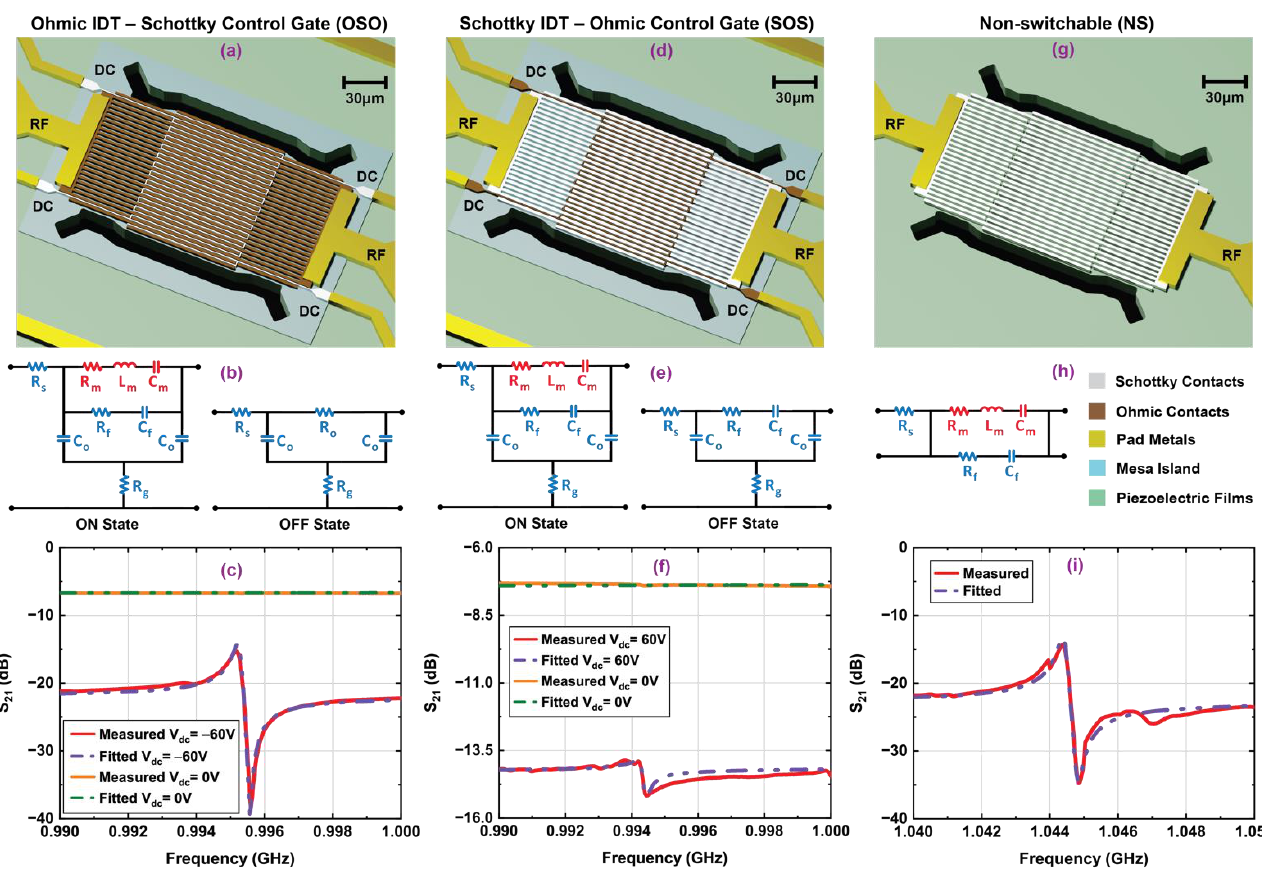
Figure 5. Three-dimensional schematic representation, equivalent circuit models and measured frequency responses along with fitted curves for switchable resonators: ( a – c ) Ohmic – Ohmic IDT with Schottky control gate (OSO), ( d – f ) Schottky – Schottky IDT with Ohmic control gate (SOS), and ( g – i ) non-switchable (NS) transducers. Both OSO and SOS have control gate width 0.6 µm, and all resonators have IDT width and pitch 1.96 µm. The devices were measured under vacuum with −10 dBm input RF power.